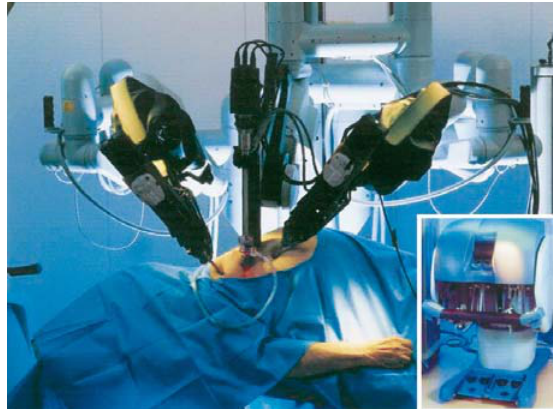
FIGURE 1. The da Vinci surgical system (Intuitive Surgical, Sunnyvale, CA) consists of a central arm that controls the laparoscope and camera as well as two side arms that are used to control a variety of grasping and cutting instruments. The surgeon can activate either the two side arms to direct the instruments or the central arm to adjust the surgical view. (Figure reprinted from Surgical Endoscopy 18(12), 1694–1711, 2004. With kind permission of Springer Science and Business